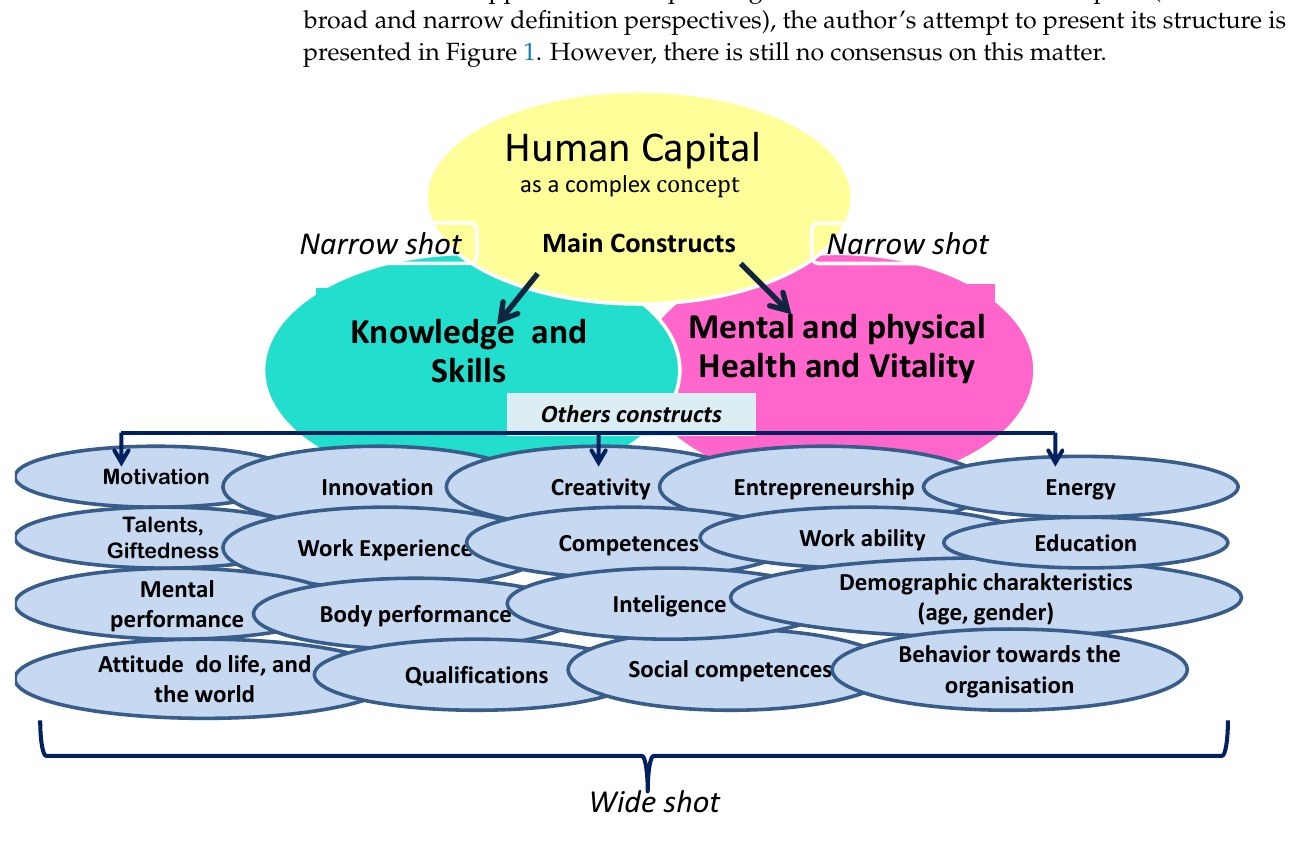
Figure 1. The Human capital structure in light of the definition in the narrow and wide shots. Main constructs. Source: own elaboration based on